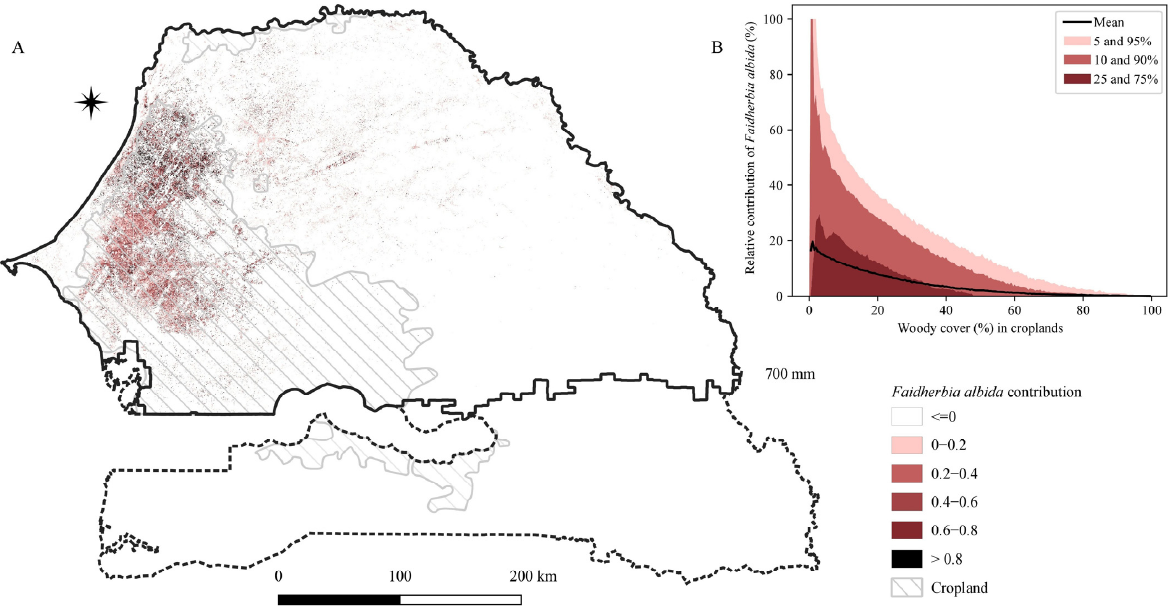
Figure 7. ( A ) Map of relative contribution of Faidherbia albida canopy cover to the cover of all woody plants shown as a percentage at the hectare scale. The rainfall zones are derived from the CHIRPS long-term (1981–2019) yearly average. ( B ) Relation between the relative contribution of Faidherbia albida to canopy cover in croplands. The land use/cover map of 2019 is provided by Copernicus Global Land Service at 100-m resolution.